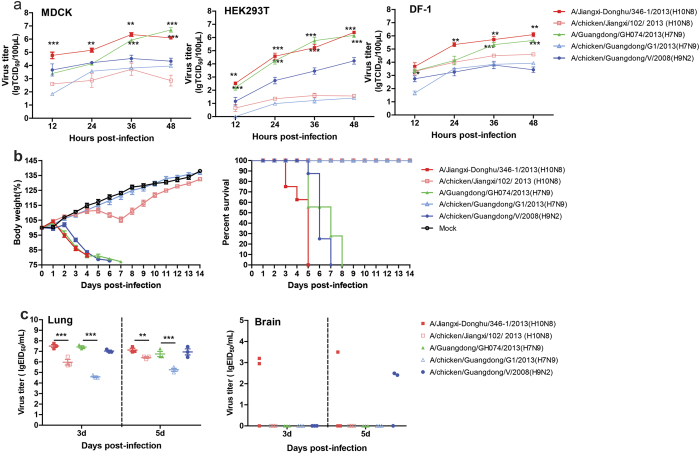
Growth kinetics and pathogenicity of H10N8 and H7N9 viruses.(a) Growth kinetics of H10N8, H7N9, and H9N2 viruses in cultured cells. Confluent MDCK, HEK293T, and avian DF-1 cells were infected with the indicated viruses at a multiplicity of infection (MOI) of 0.01. Virus titers were determined by using the 50% tissue culture infectious dose (TCID50) assay. The virus titers are means ± standard deviations (SD) (n = 3). Statistical difference between the human viruses compared with their respective avian-origin viruses were labeled (*P < 0.05, **P < 0.01, ***P < 0.001). (b,c) Pathogenicity and virus replication of H10N8, H7N9, and control H9N2 viruses in mice. Group of mice were intranasally infected with 106 EID50 of each virus or mock-infected with PBS. Body weight and case fatality rate are shown in (b) and virus replication in mouse lungs and brains on 3 and 5 dpi is shown in (c). The percentage weight loss or gain from each group and each time point are expressed as means ± SD of eight infected mice. Virus titers in tissues were determined using EID50 assays and each datapoint represents the virus titer from an individual animal (**P < 0.01, ***P < 0.001).